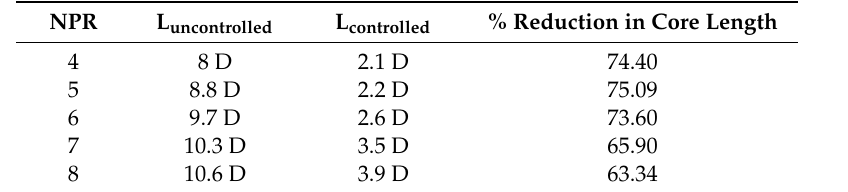
Table 1. Core lengths for uncontrolled and controlled jet at di ff erent NPRs along with the percentage reduction in core length.